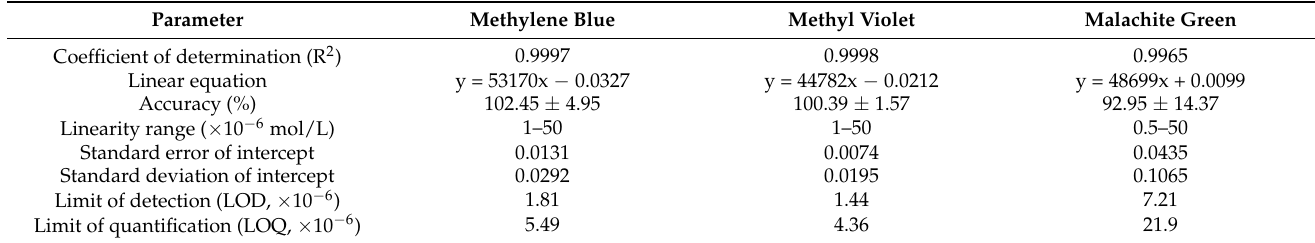
Table 3. Analytical performance of the proposed microextraction